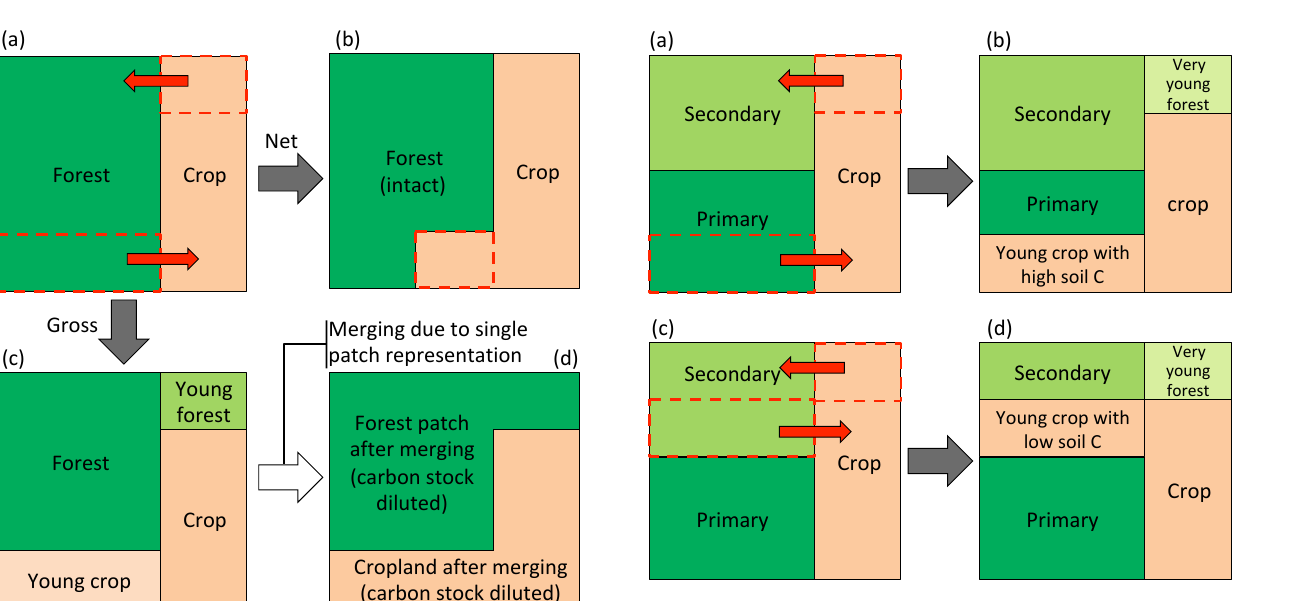
Figure 2. Gross land use change involving forests with different ages under a model scheme capable of representing sub-grid land cohorts. The figure is adapted from Stocker et al. (2014). LUC here is similar to in Fig. 1, except that forest is no longer a single ageless patch but consists of two patches of primary and secondary forests, i.e. having an age structure. (a) The same area of forest is converted to cropland as in Fig. 1a but conversion is made from primary forest. legacy soil C than that in (b)